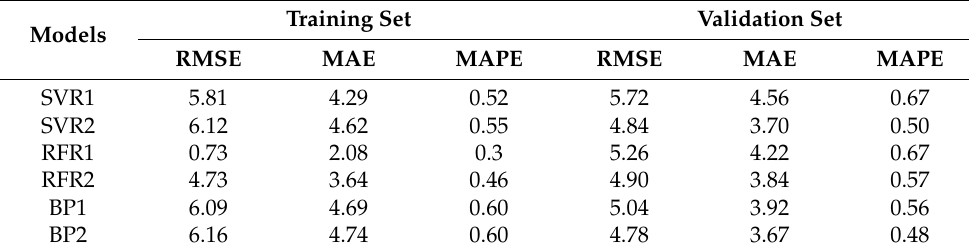
Table 7. Comparison of SVR, RFR and BP neural network prediction models.